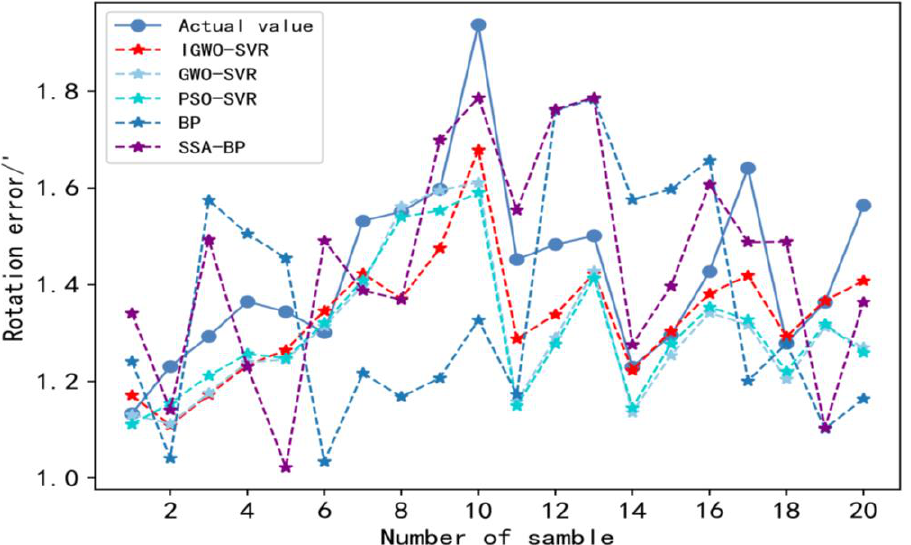
Figure 11. Prediction results of rotation error for different models. Table 7. Prediction results of rotation error for different models.